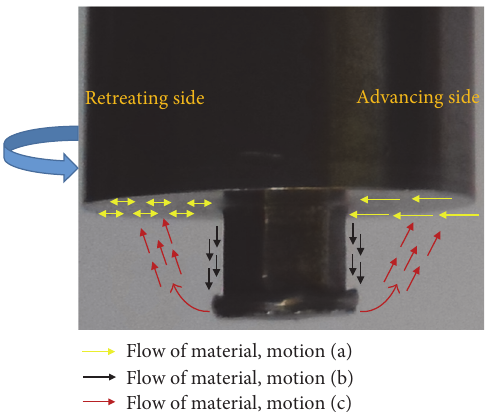
Figure 11: Material flows on the SHBH pin profile according to three principal